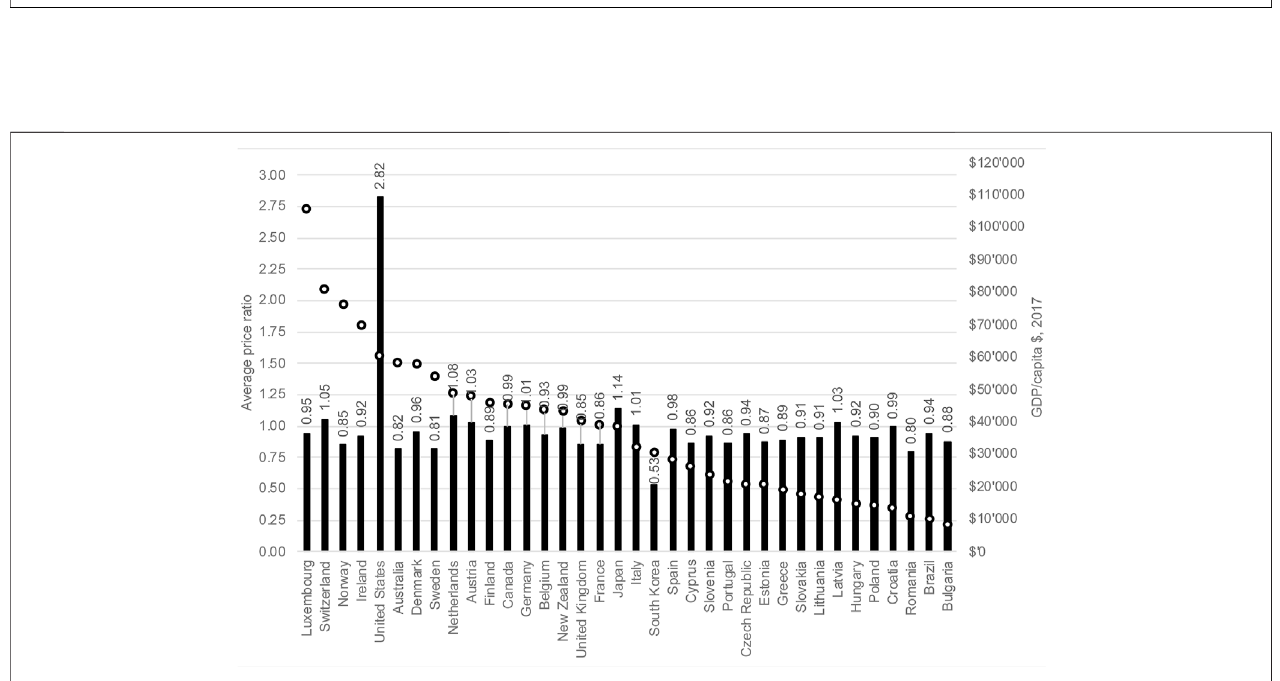
FIGURE 2 | Relative launch product prices vs